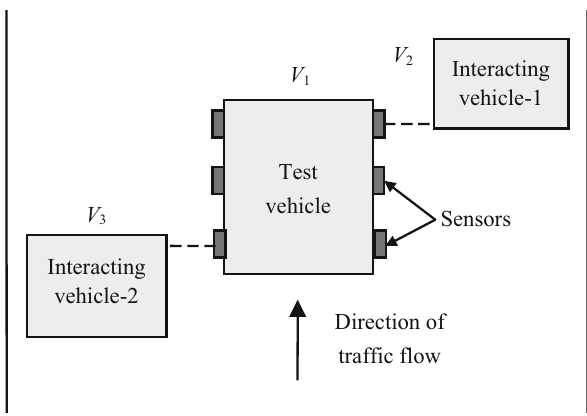
Fig. 11 Necessary condition of detecting interacting vehicles for multiple